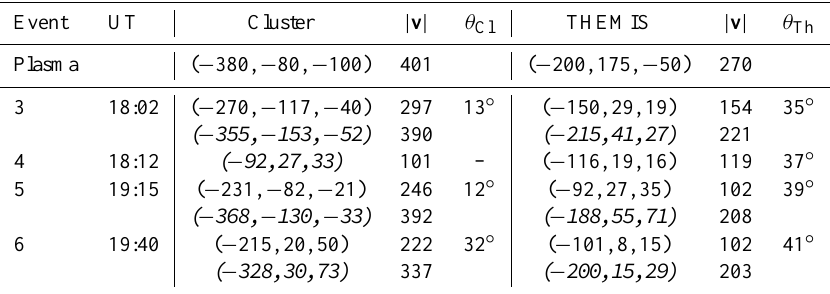
Table 3. Shown are the plasma velocity as measured by the spacecraft an the velocity of the magnetic structures resulting from the timing analysis. The time at which the timing analysis has been performed is given for THEMIS A. Also the angle θ between the plasma flow velocity and the structure normal velocity is given. The velocities in italics are the plasma velocity projected onto the normals of the structure. The plasma velocity did not change significantly over the interval and an average value is used for